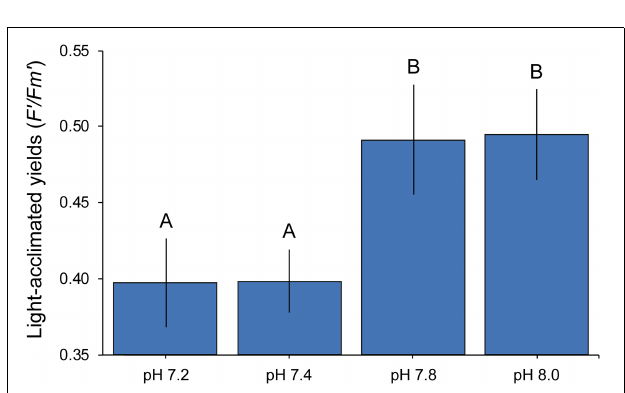
FIGURE 6 | Mean ( ± 1 SE) photochemical efficiencies of Symbiodinium microadriaticum CCMP2467 across pH treatments. Letters indicate overall similarities (e.g., AA) or differences (e.g., AB) between treatments as determined by SNK post hoc